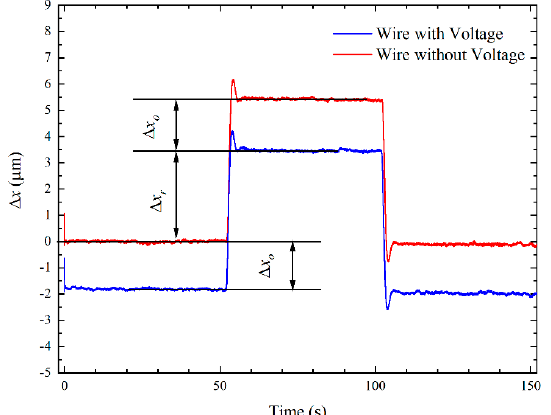
Figure 18. The influence of wire voltage on arm displacement reading.